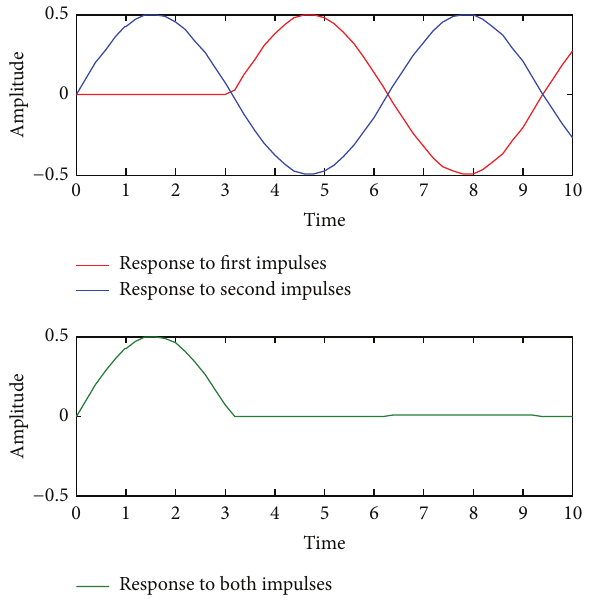
Figure 13: Response of dynamic system to two sequent impulses.